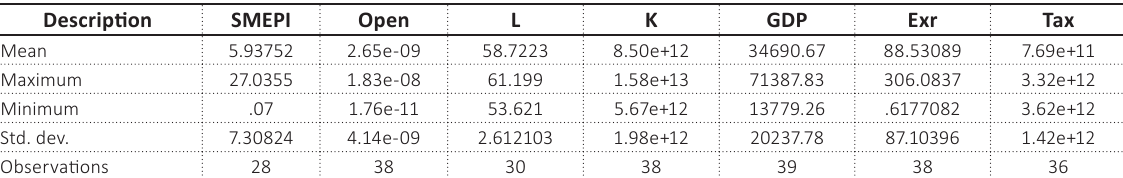
Table 2. Descriptive statistics